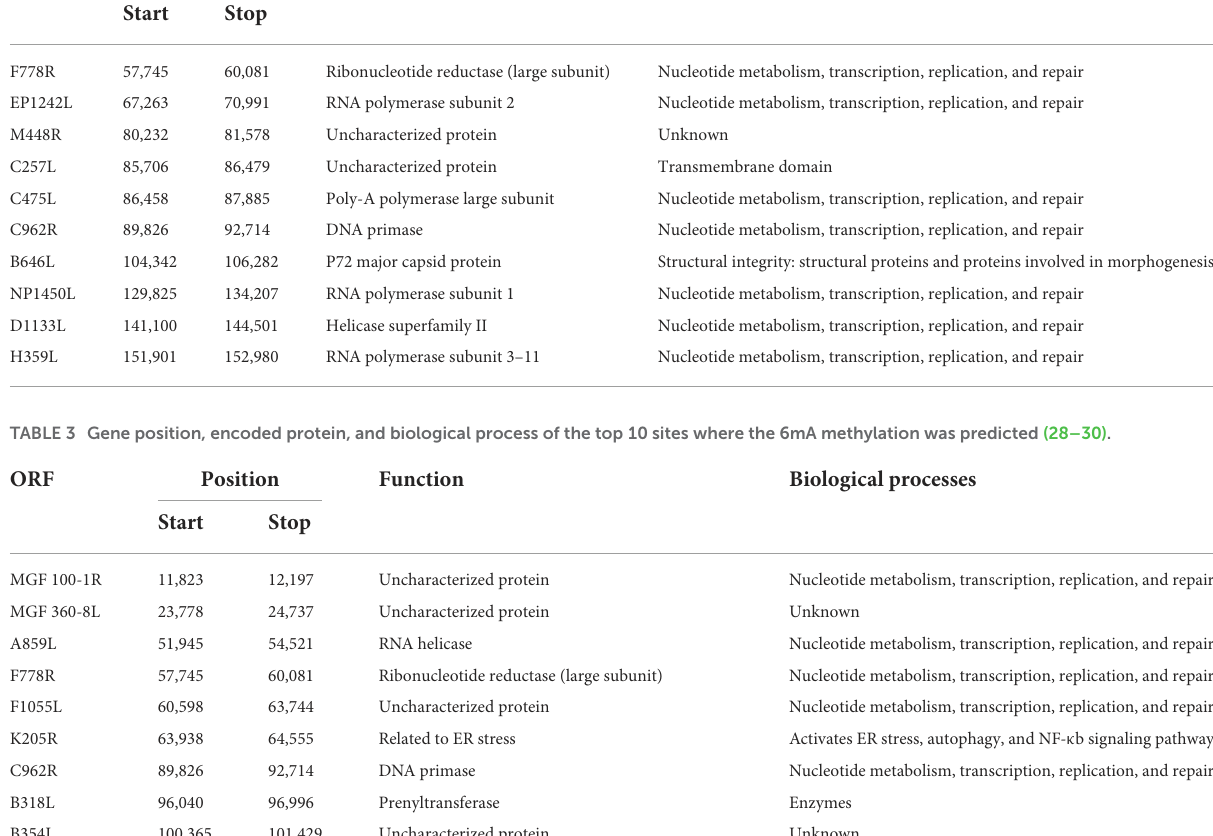
pp.220 polyprotein precursor of p150, p37, p14,